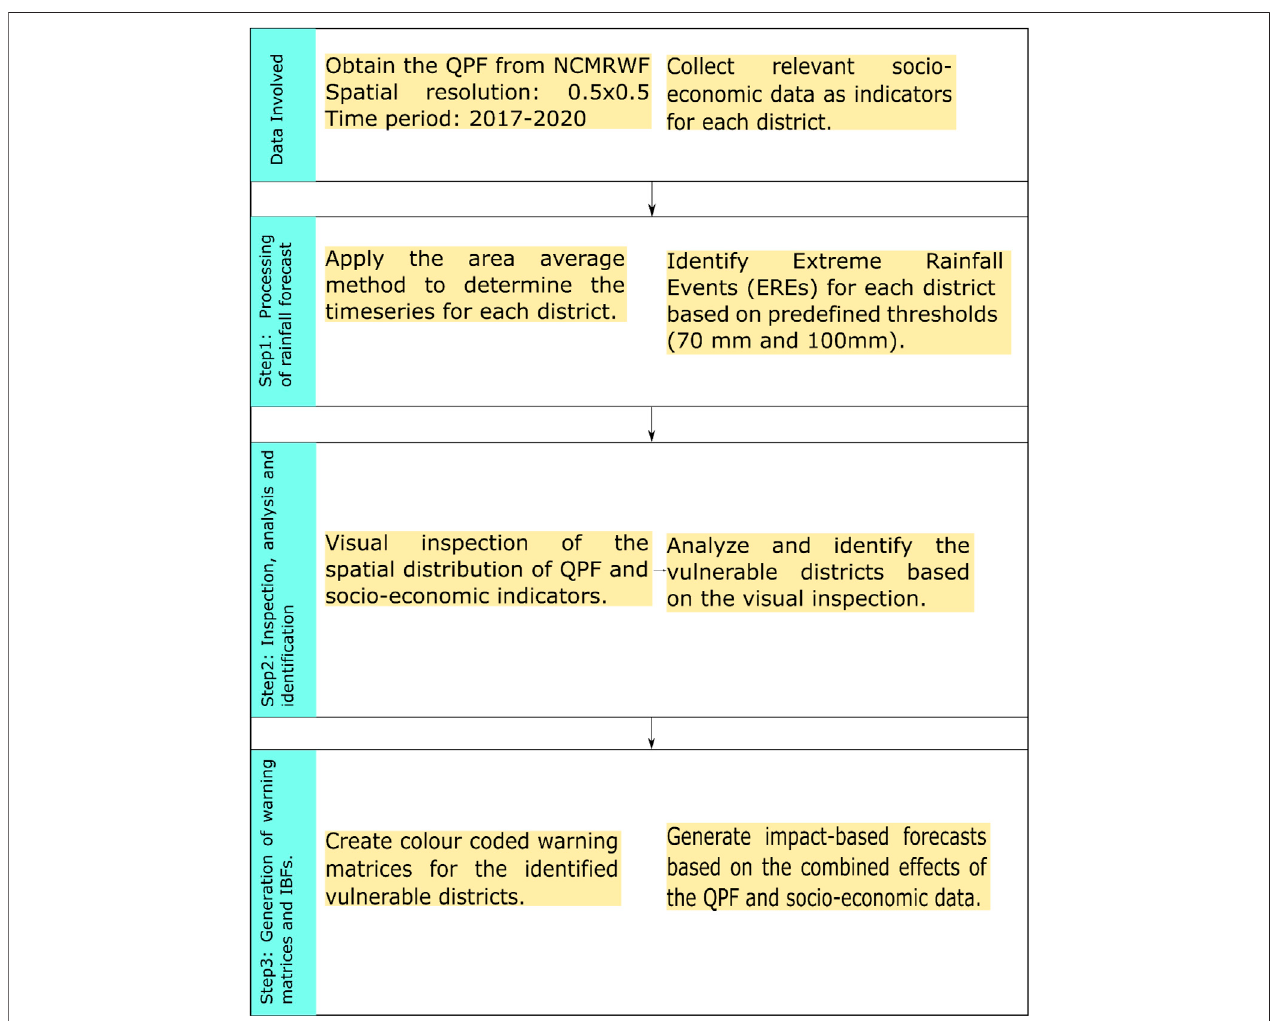
FIGURE 2 | The methodological framework applied to generate IBFs and warning matrices in the study.